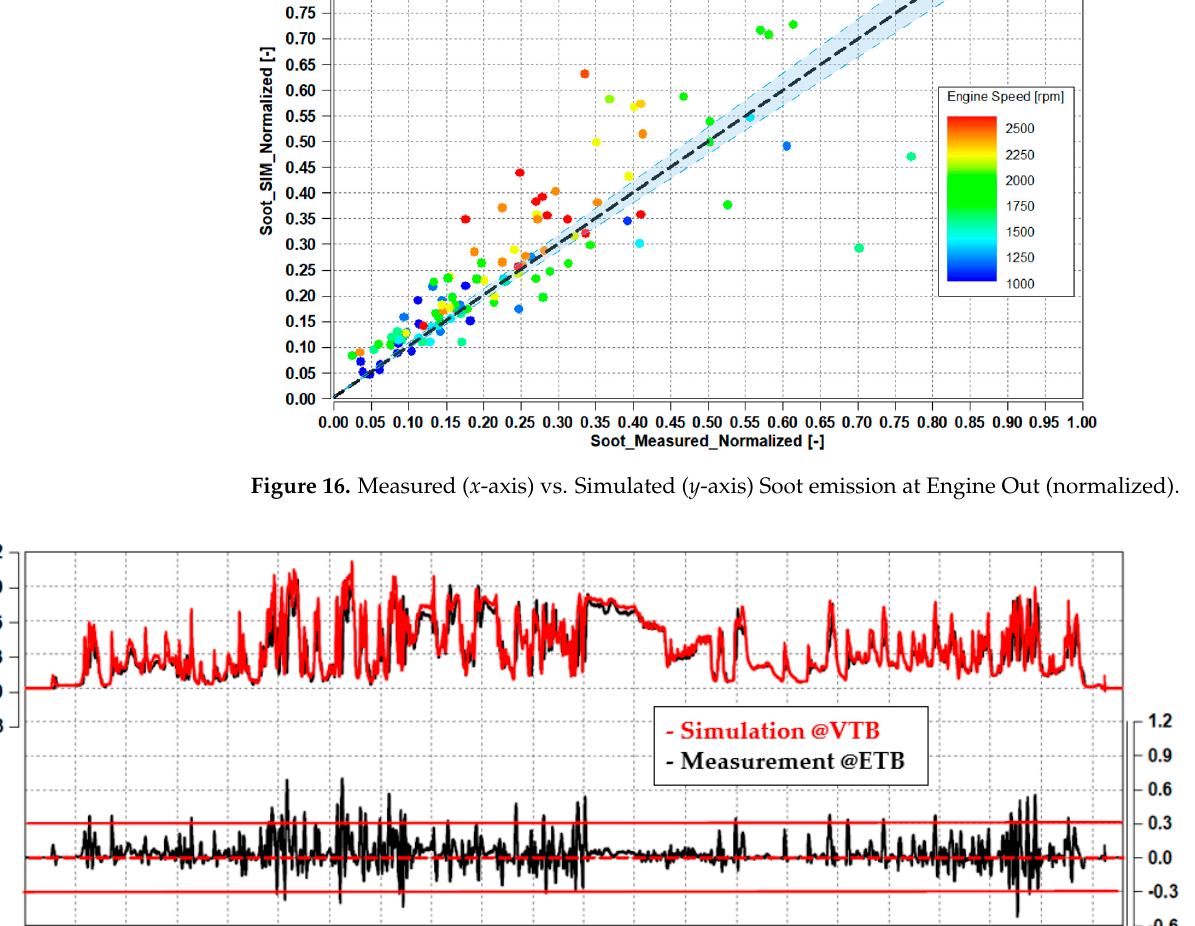
Figure 17. Top: Simulated (red) vs. experimental (black) NO x Engine Out (normalized). Bottom: Difference between simulated and measured NO x Engine out signals (normalized).